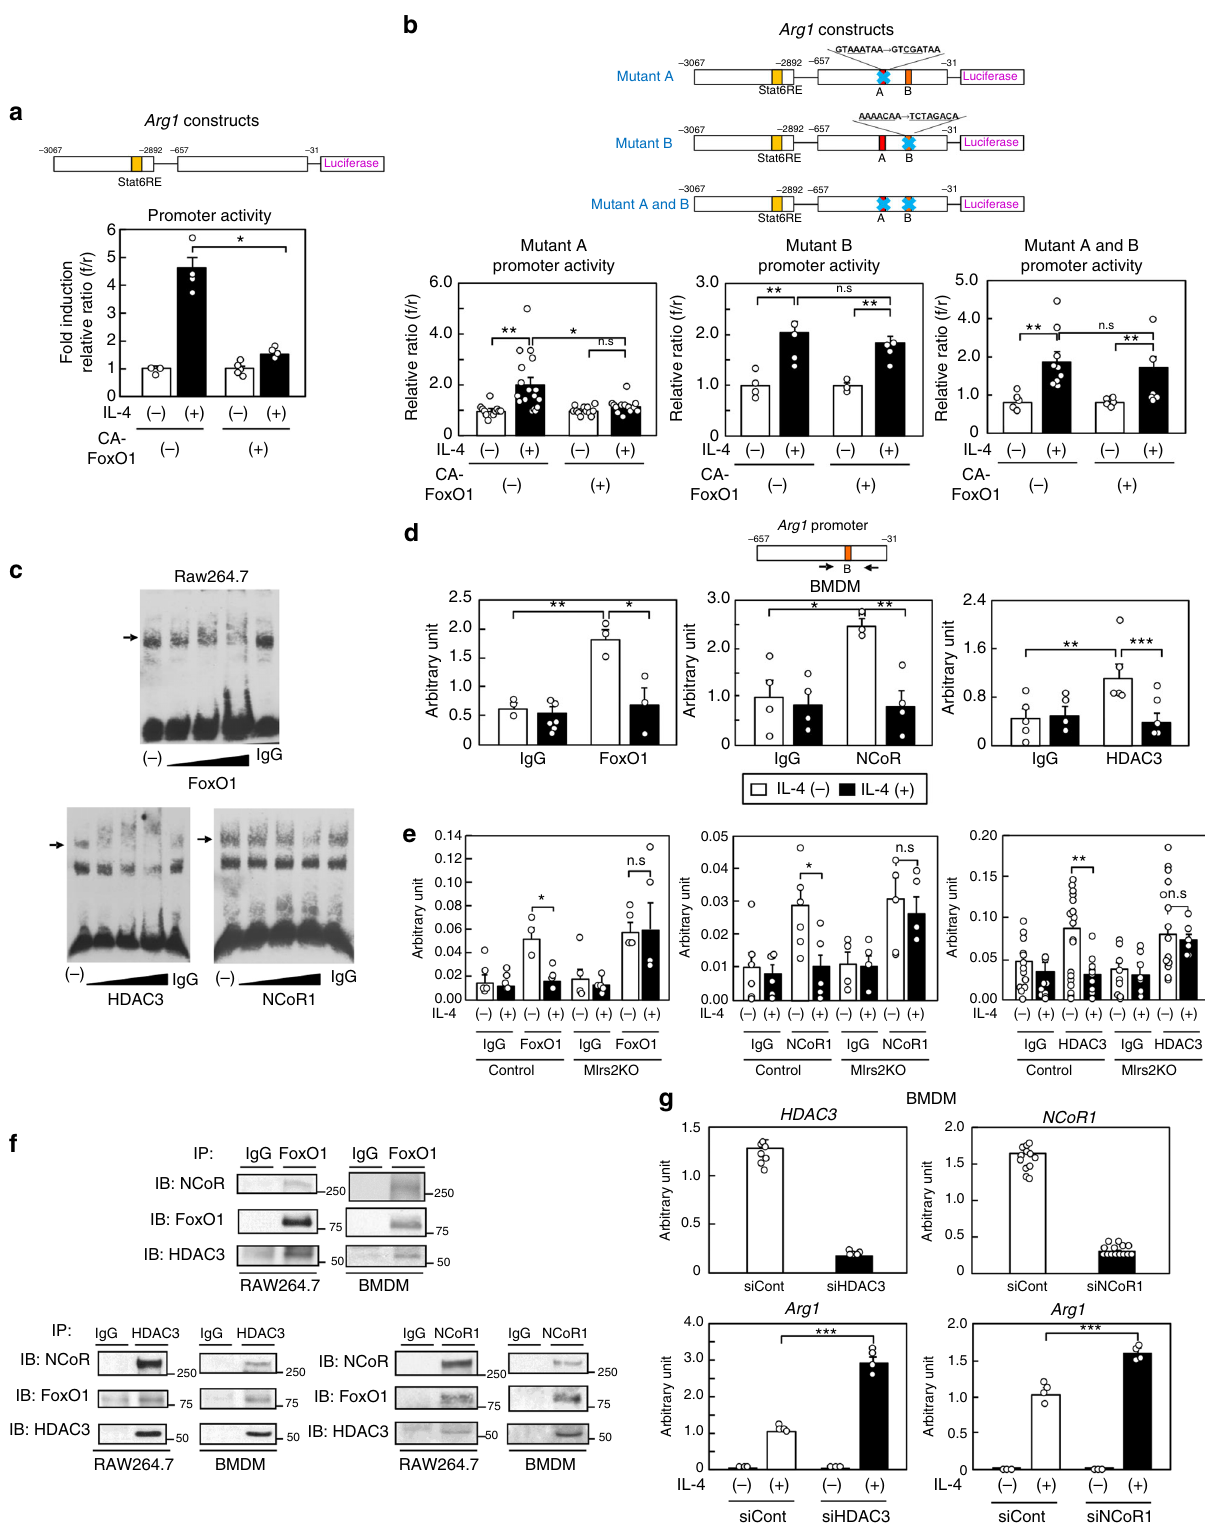
Fig. 3 FoxO1 bound to HDAC3 and NCoR1 to form a corepressor complex. a Arg1 promoter activity after IL-4 stimulation with or without CA-FoxO1 transfection ( n = 4 – 5). b Mutant A, B, and A plus B Arg1 promoter activities after IL-4 stimulation with or without CA-FoxO1 transfection ( n = 5 – 6). c The binding of DNA nucleotides of the B area of the Arg1 promoter and proteins, and the blocking of the DNA-protein complex formation in a dose-dependent manner by FoxO1, HDAC3 and NCoR1 antibody were determined by EMSA in RAW264.7 cells. d Chip-qPCR using FoxO1, HDAC3 and NCoR1 antibody in the BMDM of the C57BL/6 mice before and after IL-4 stimulation ( n = 5 – 10). e Chip-qPCR using FoxO1, HDAC3 and NCoR1 antibody in the BMDM of the M Irs2 KO mice before and after IL-4 stimulation ( n = 3 – 16). f Co-immunoprecipitation (Co-IP) with FoxO1, HDAC3 and NCoR1 antibody without IL-4 stimulation in the Raw 264.7 cells and BMDM. g Expression levels of Arg1 in the BMDM of the C57BL/6 mice after IL-4 stimulation with siHDAC3 or siNCoR1 transfection ( n = 3 – 8). The data are mean ± SEM. followed by one-way ANOVA with a post hoc test. * P < 0.05; ** P < 0.01; *** P <